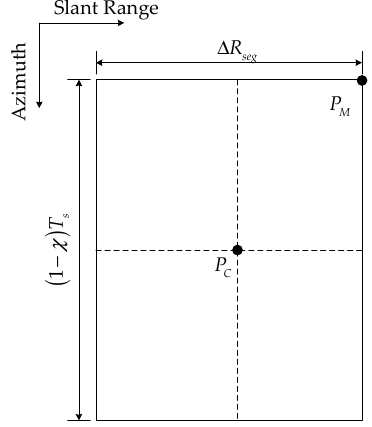
Figure 19. Points in one sub-block diagram. Point P C is located at the sub-block center, whereas P M is a set denoting every point at the corner.